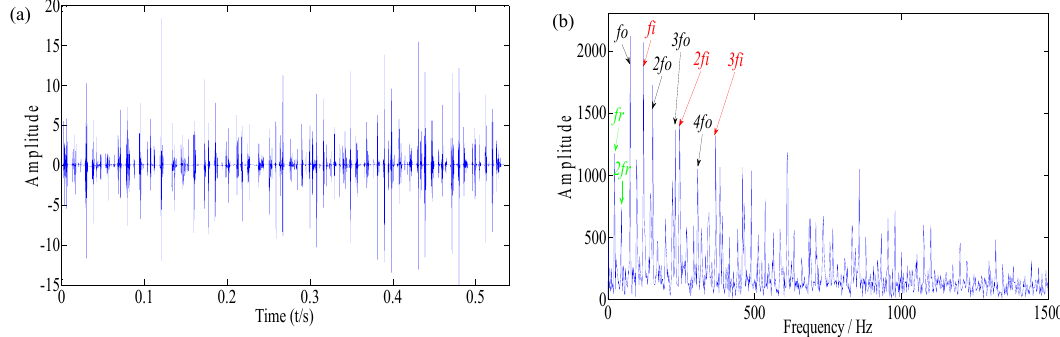
Figure 15. The analysis results of case 2 with the parallel dual-Q-factor bases sparse decomposition: ( a ) Low resonance component; ( b ) envelope spectrum.